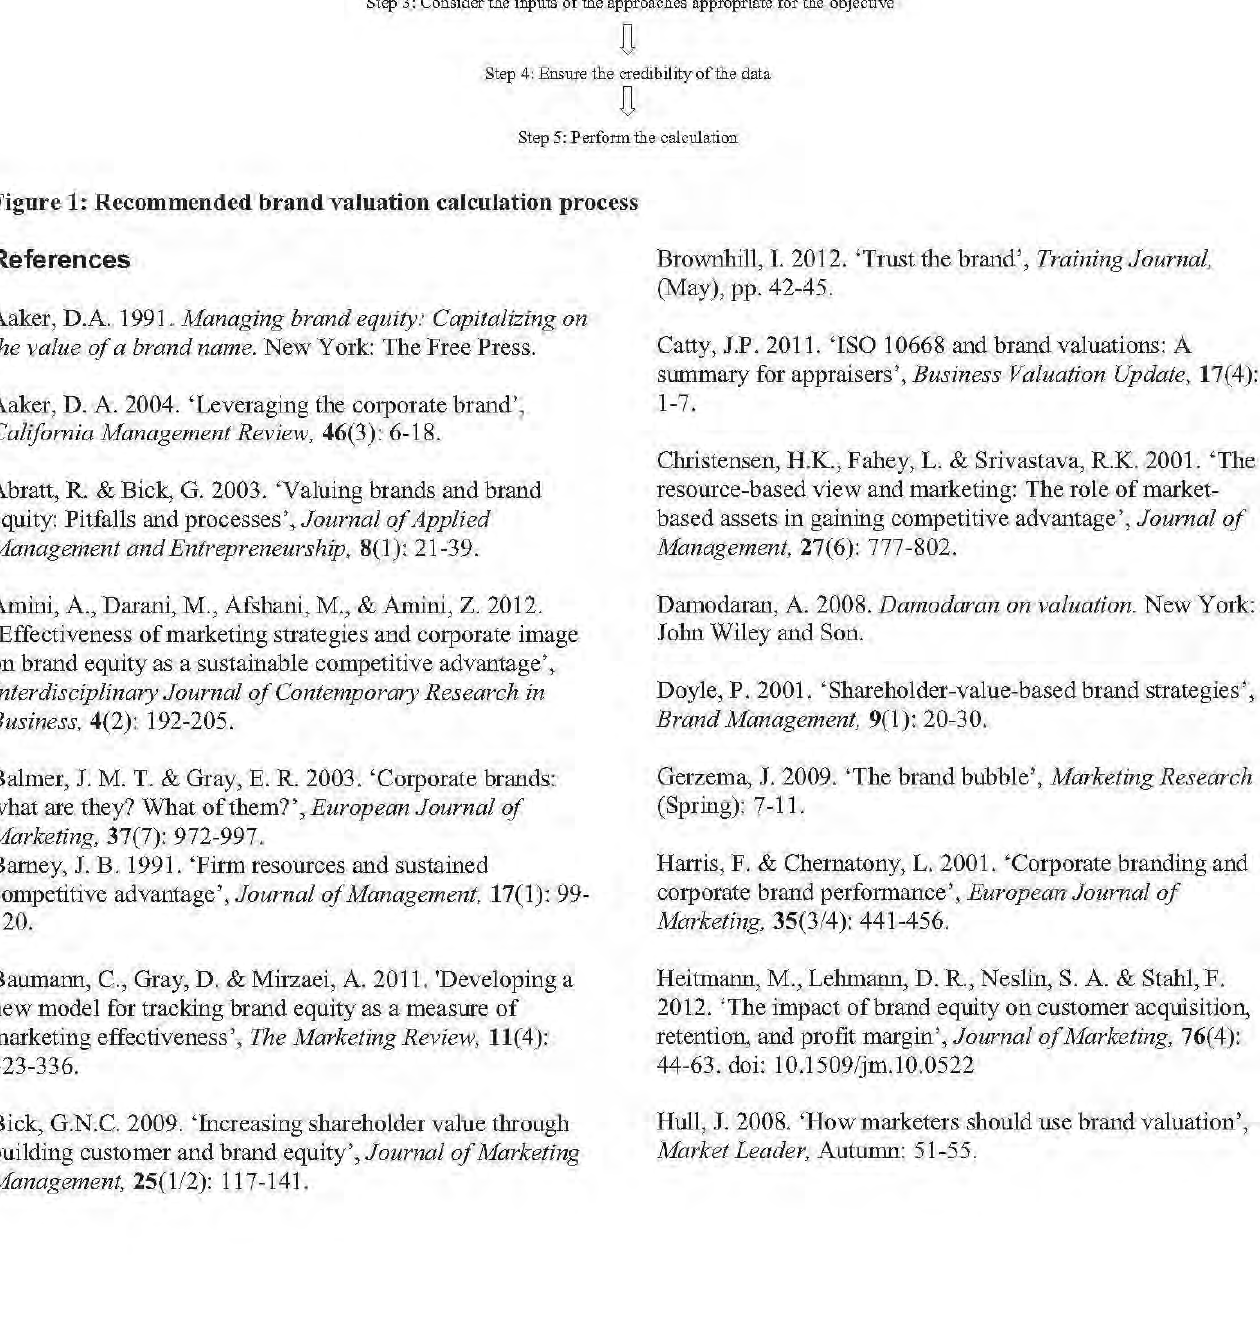
Figure 1: Recommended brand valuation calculation